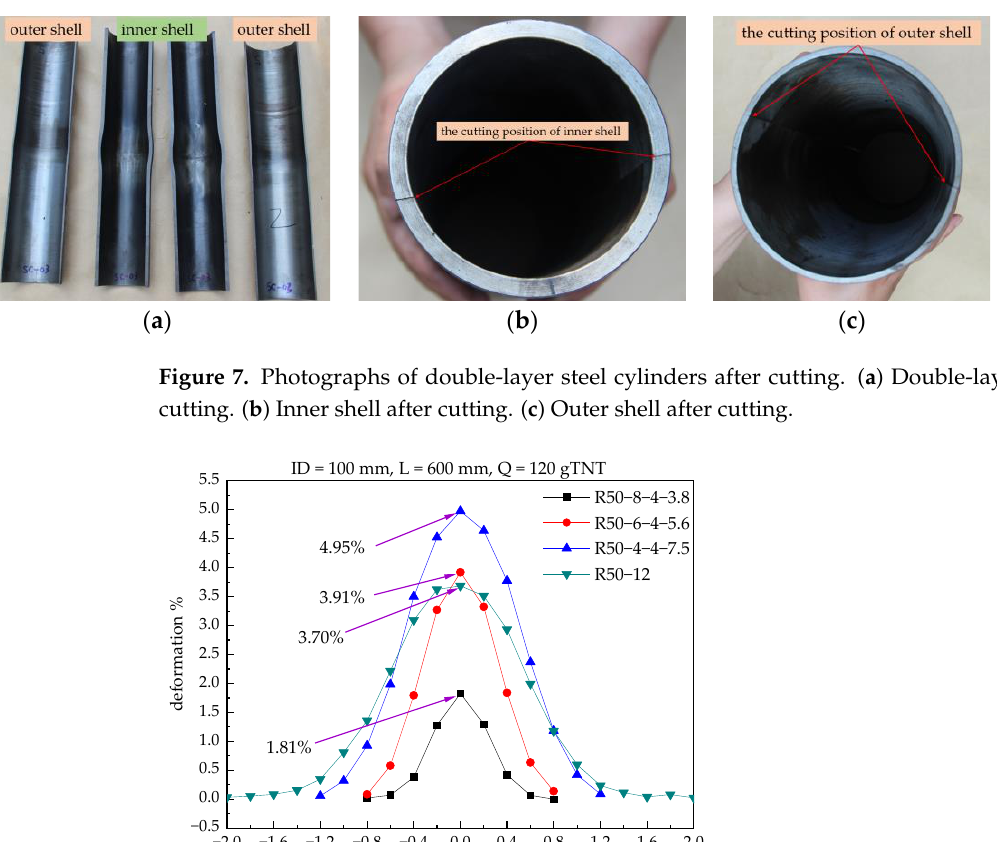
6 of 15 Figure 6. Displacement of double-layer shells measured by PDV. The maximum radial displacement of the outer cylinder was measured to be 2.54 mm after the experiment, compared to which the error of PDV measurement was about 2.8%. After incising the double-layer cylinder, the maximum radial displacement of the inner cylinder was measured to be 5.72 mm after the experiment, compared to which the error of PDV measurement was about 5.4%. It can be concluded that the radial displacement measured by PDV was in accordance with that measured after the experiment. The maximum velocities of the three double-layer cylindrical shells under 120 gTNT explosive yield were measured by PDV. The maximum velocities of the three experiments are shown in Table 2. The maximum velocities of the inner shell are reduced with the increase in the thickness of the inner cylindrical shell. The maximum velocities of the outer shell increase at first and then decrease with the increase in the thickness of the inner shell. Table 2. The maximum velocities of the inner and outer shells. Number h 1 /mm Δ/mm h 2 /mm Maximum Velocity of the Inner Shell (m/s)